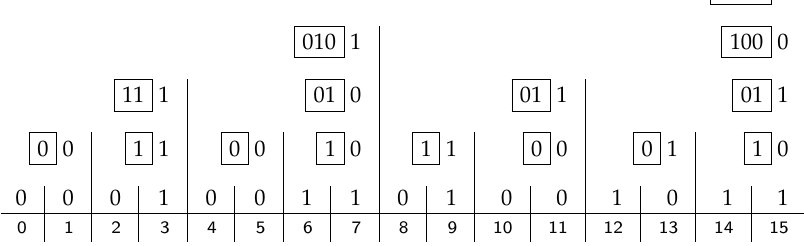
Figure 3. Building the vector of parity